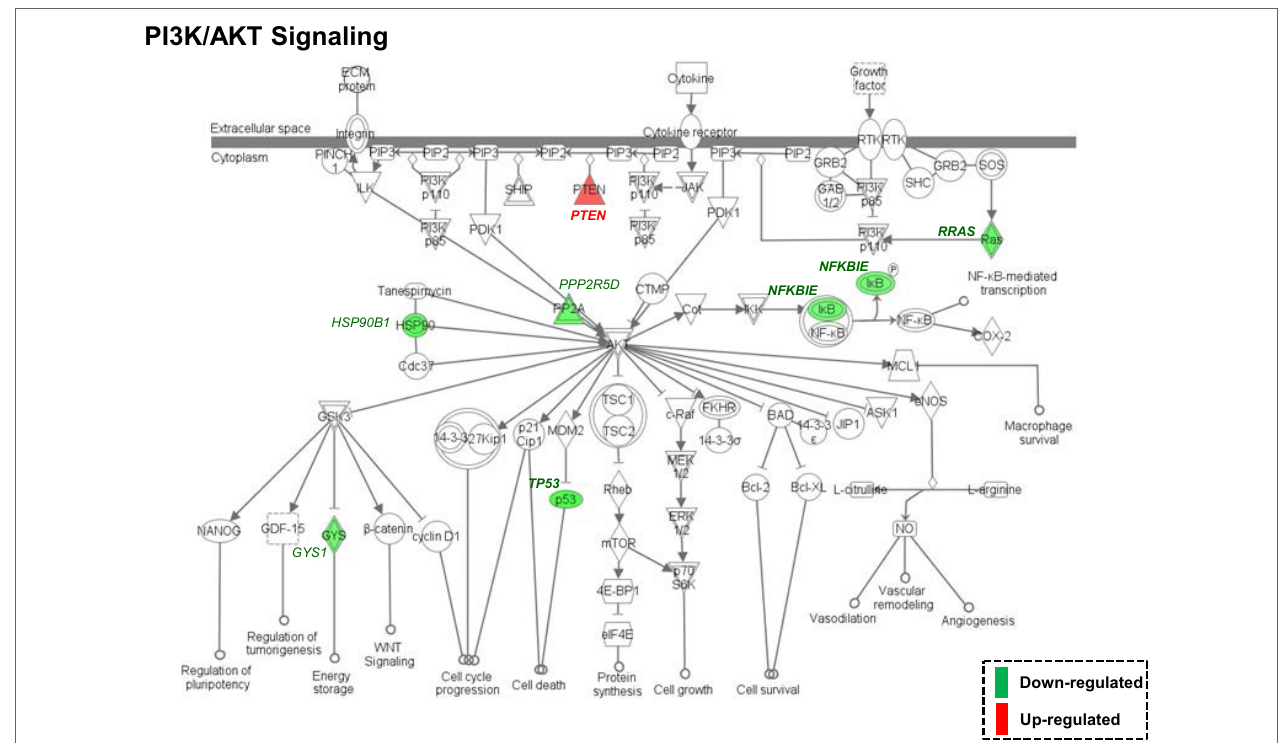
FigUre 2 | Enriched PI3K/AKT signaling pathway, identified by Ingenuity Pathway Analysis based on 300 differentially expressed genes (nominal P values < 0.05) detected exclusively in both week 8 and week 12 topiramate (TPM) groups. Symbols with a single border indicate single genes. Those with a double border indicate complexes of genes or the possibility that alternative genes might act in the pathway. Red color symbols indicate upregulated gene clusters, and green color symbols represent downregulated gene clusters. At both time points, GYS1 , HSP90B1 , NFKBIE , PPP2R5D , RRAS , and TP53 were consistently downregulated, and PTEN was consistently upregulated. If a gene was detected by both the ordinary Student’s t -test and the empirical Bayes moderated t -test in either the week 8 TPM group or week 12 TPM group, that gene’s corresponding symbol was highlighted in bold